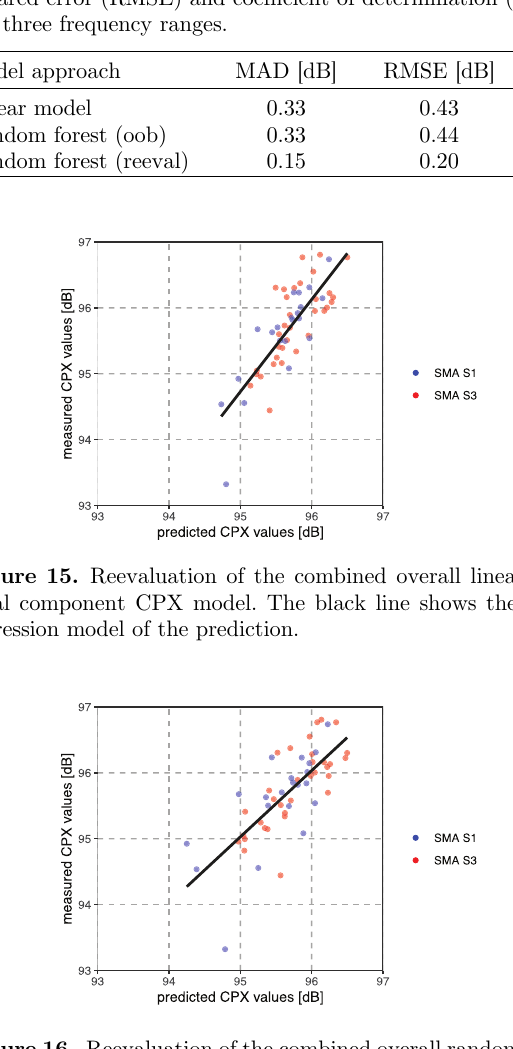
Figure 16. Reevaluation of the combined overall random forest CPX model based on the out-of-bag prediction. The black line shows the linear regression model of the